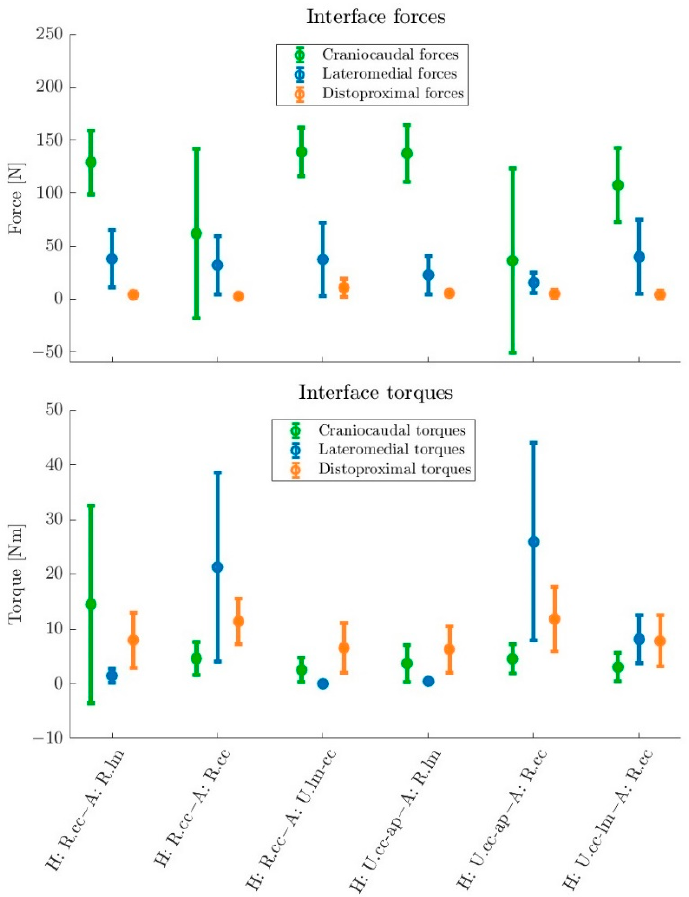
Figure 6. Mean forces and torques in the arm interface with standard deviations for six concepts averaged over left and right arm bracing and the motion sequence T5. The diagrams show absolute torques around the craniocaudal (green) and distoproximal (orange) axis and absolute forces in the direction of the lateromedial (blue) and distoproximal (orange) axis. For craniocaudal forces and lateromedial torques averages of signed values are shown.